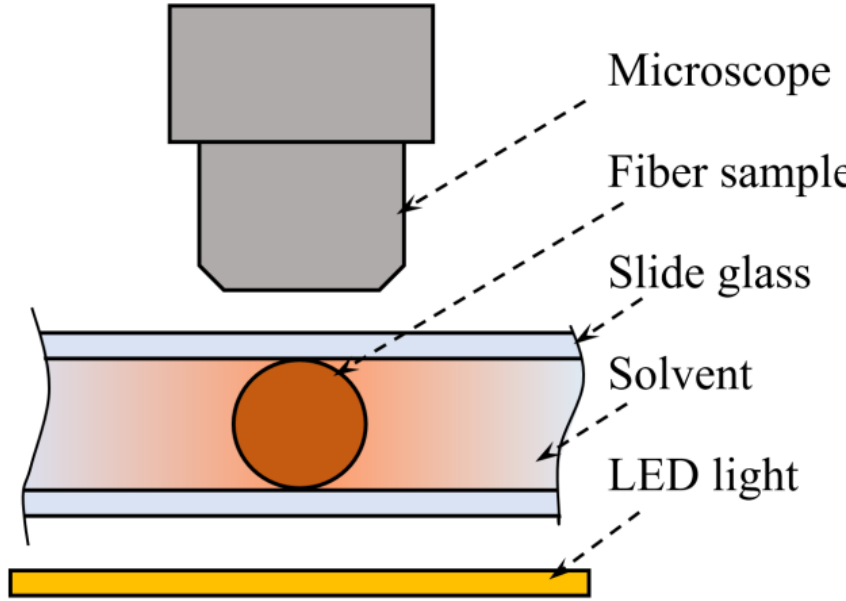
Figure A2. Scheme of the dissolution rate examination method.